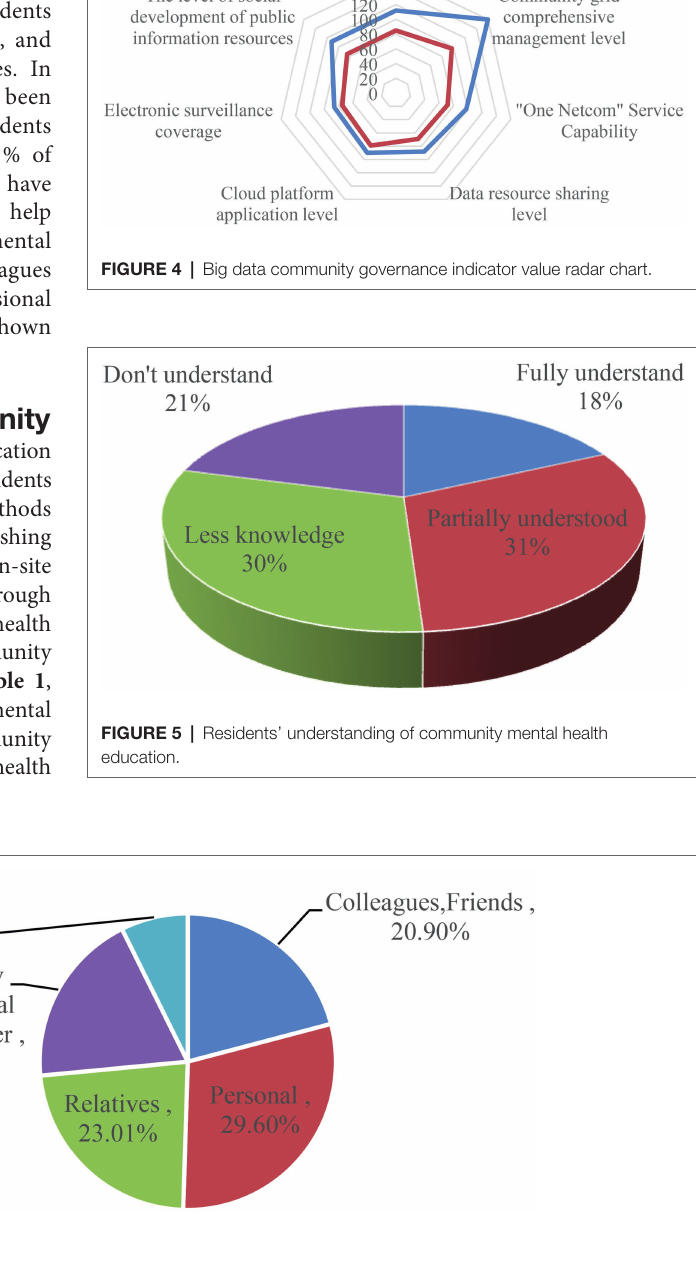
FIGURE 6 | Community residents seeking help.